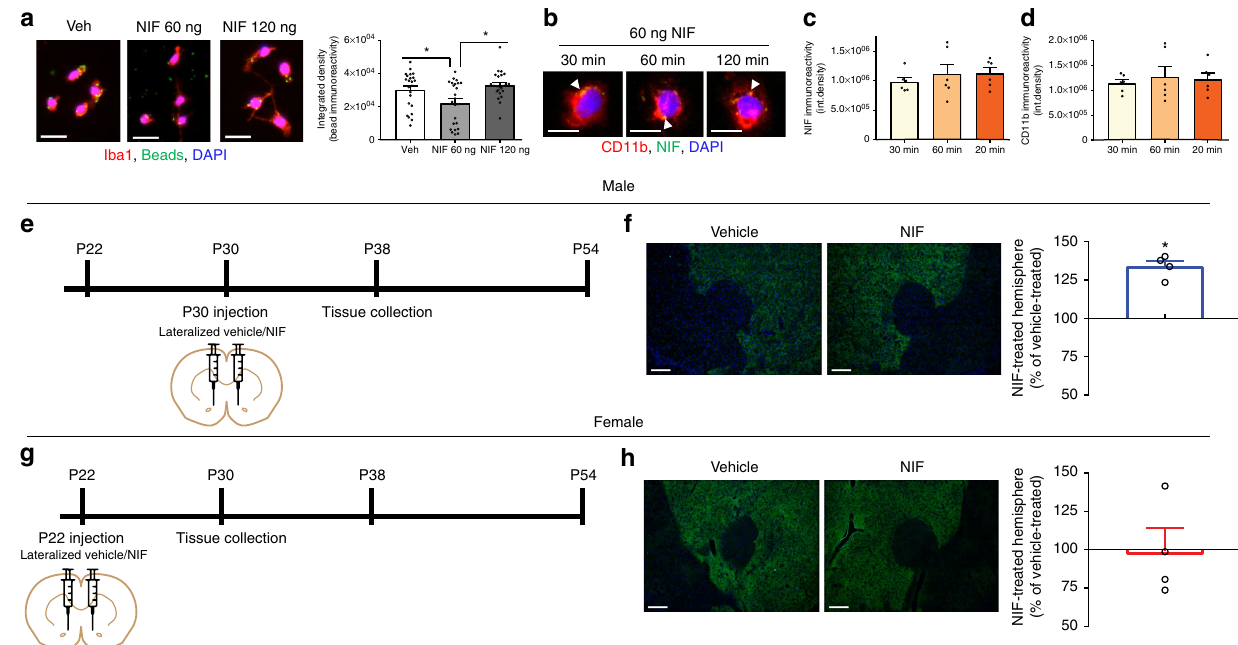
Fig. 3 C3 – C3R interactions mediate developmentally-typical D1r elimination in vivo in males, but not females. Neutrophil inhibitor factor (NIF), a peptide that binds speci fi cally to the CD11b subunit of C3 receptors (C3Rs), was assessed for its ef fi cacy in reducing microglial phagocytic activity ex vivo. a In microglia isolated from whole brain, 60 ng, but not 120 ng NIF inhibited microglial phagocytosis of fl uorescent beads (Table 3A). Representative images precede histograms; scale bar equals 20 µ m. n = 4, with 2 replications/condition. b Microglia were isolated from whole brain and incubated with 60 ng NIF, and then immunocytochemically assessed for NIF and CD11b at 30, 60, and 120 min. Closed arrow heads indicate NIF (green) immunoreactivity. Scale